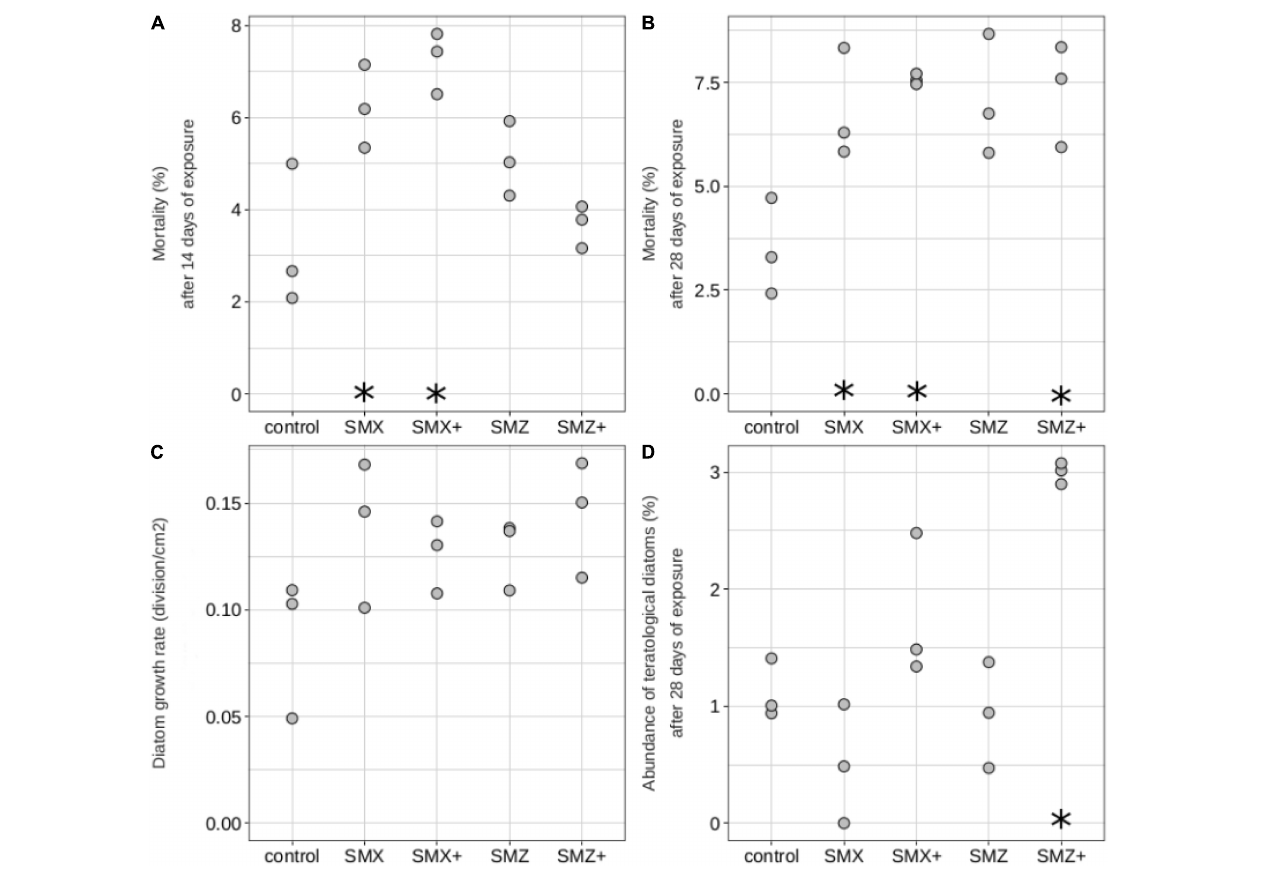
FIGURE 3 | Diatoms mortality (in%, on Day 14: A , and on Day 28: B ), diatom growth rate (in division cm − 2 , C ), abundance of teratological diatoms (in%, on Day 28: D ) of biofilms non-exposed (control) and exposed to sulfamethoxazole (500 ng L − 1 : SMX, 5,000 ng L − 1 : SMX+) or sulfamethazine (500 ng L − 1 : SMZ, 5,000 ng L − 1 : SMZ+). Significant differences ( p < 0.05) between controls and biofilms exposed to antibiotics are indicated by